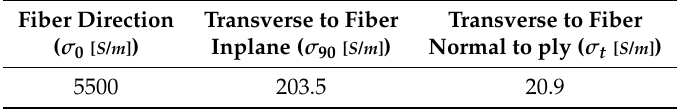
Table 1. Orthotropic conductivity σ values used for the finite element analysis models